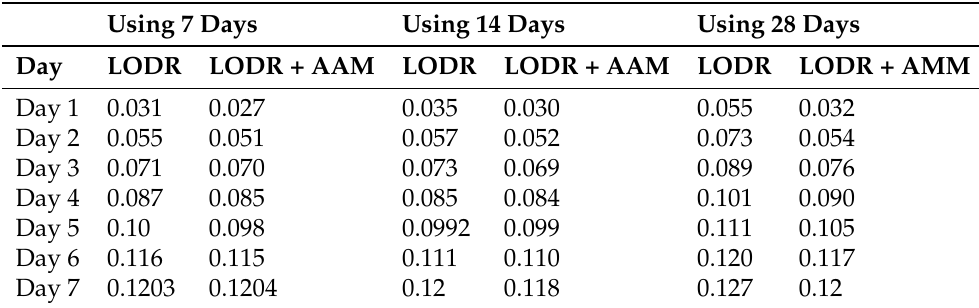
Table 1. Comparison of the mean absolute errors of the predicted LOD using the 1D CNN before and after introducing the AAM using different input sizes (7, 14, 28). Units: (ms/day). Using 7 Days Using 14